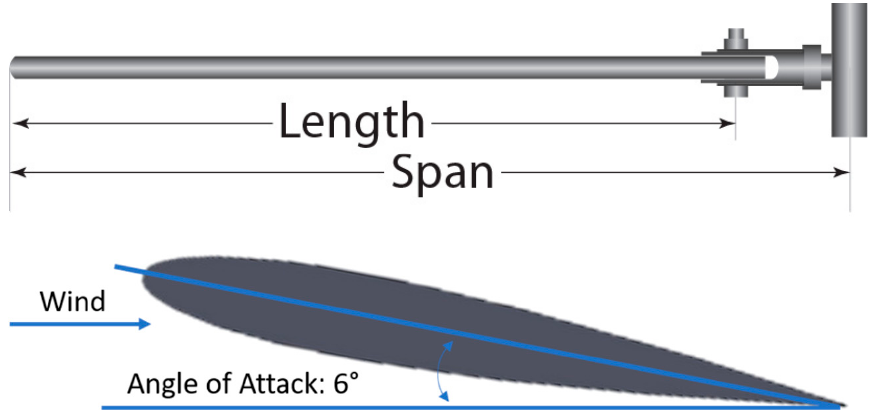
Figure 6. Blade length, span, and angle of attack